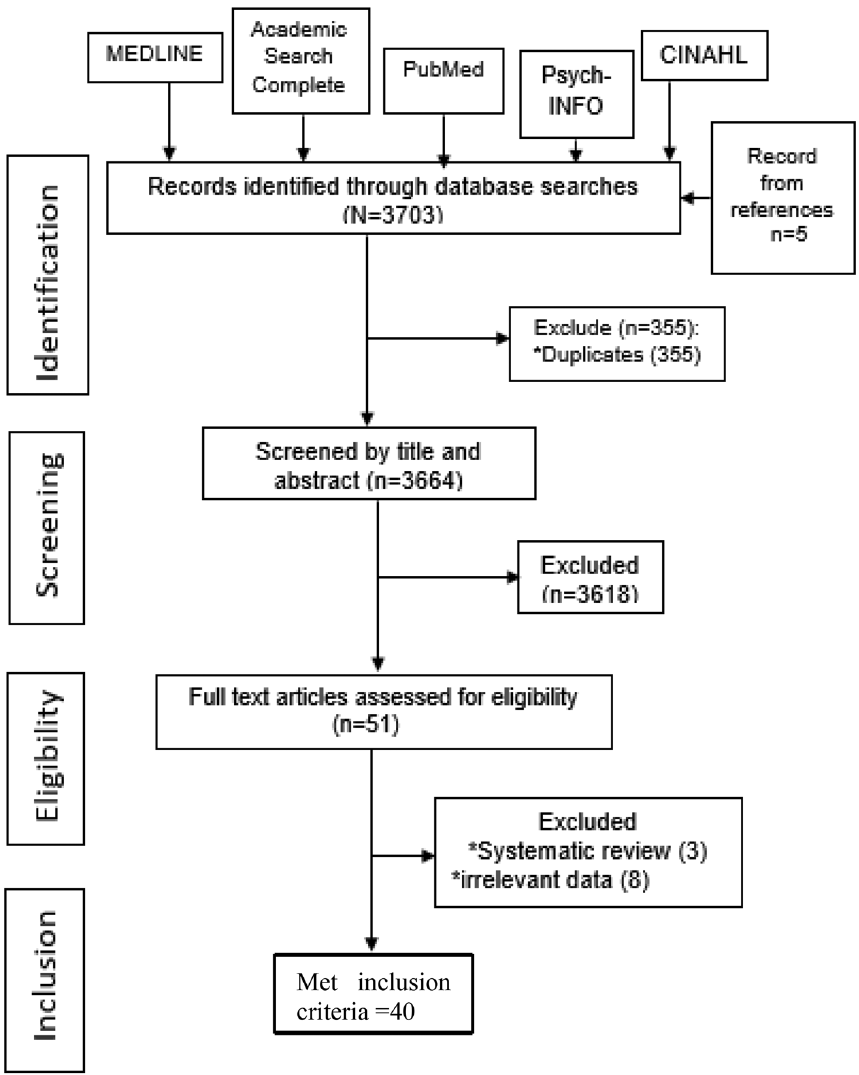
Figure 1. PRISMA flow diagram of the systematic review of articles estimating the impact of HAND on medication adherence, activitiesof daily living quality of life and frailty in the modern era